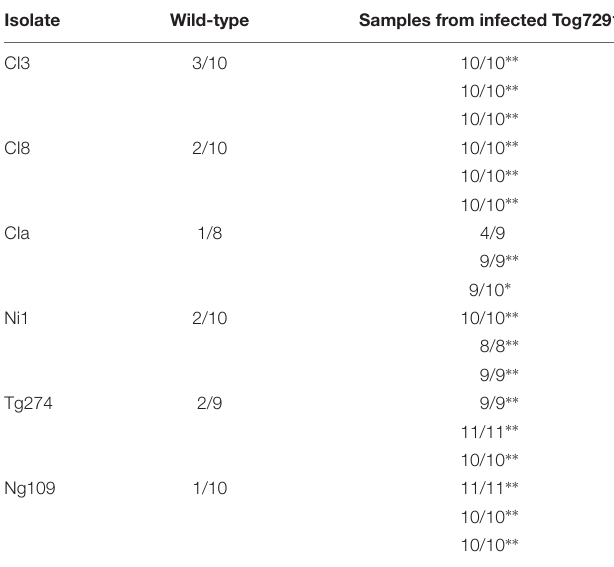
TABLE 2 | Back-inoculation assays with infected Tog7291